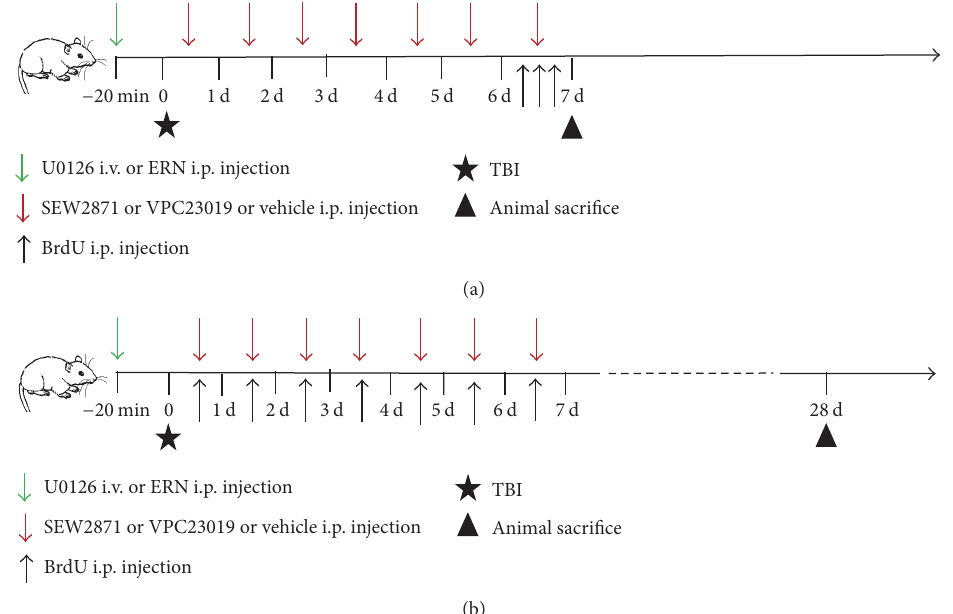
Figure 1: Schematic diagram of drugs and 5-bromo-2-deoxyuridine (BrdU) administration. The time-point of traumatic brain injury (TBI) model establishment was defined as zero point (indicated by black pentagram). (a) For the assay of neural stem cells (NSCs) proliferation, BrdU (100 mg/kg) was injected intraperitoneally (i.p.) three times with 8-hour interval at 6 days after TBI (indicated by black arrow) and the animals were sacrificed for perfusion at 7 days after TBI (indicated by black triangle). (b) For the analysis of NSCs differentiation, BrdU (100mg/kg)wasinjectedi.p.seventimeswith24-hourinterval1–7daysafterTBI(indicatedbyblackarrow)andtheanimalsweresacrificedfor perfusionat28daysafterTBI(indicatedbyblacktriangle). SEW2871(1.0 mg/kg/day)orVPC23019(0.5 mg/kg/day)orvehicle(0.5 mL/kg/day) was administrated i.p. in rats of the corresponding group seven times within 24-hour interval 1–7 days after TBI (indicated by red arrow in (a) and (b)). Erucin (ERN, 12.5 mg/kg) or U0126 (0.2 mg/kg) was administrated i.p. or intravenously (i.v.) in rats of TBI+SEW+U0126 group 20 minutes before TBI (indicated by green arrow in (a) and